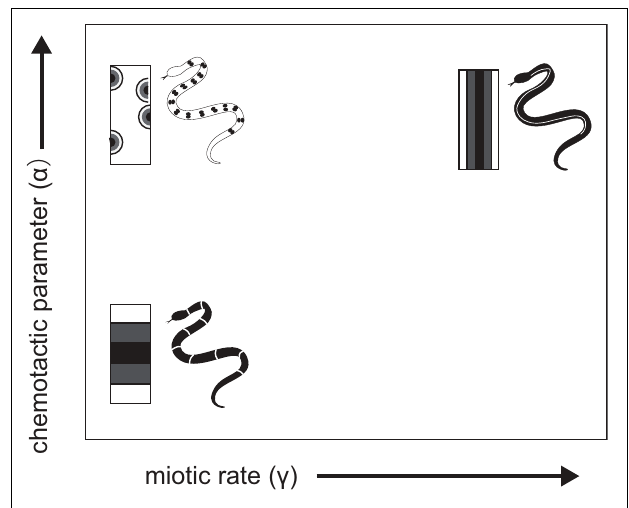
FIGURE 8 | A schematic drawing of cell -chemotaxis model mechanism of snake dorsal color pattern by Murray and Myerscough